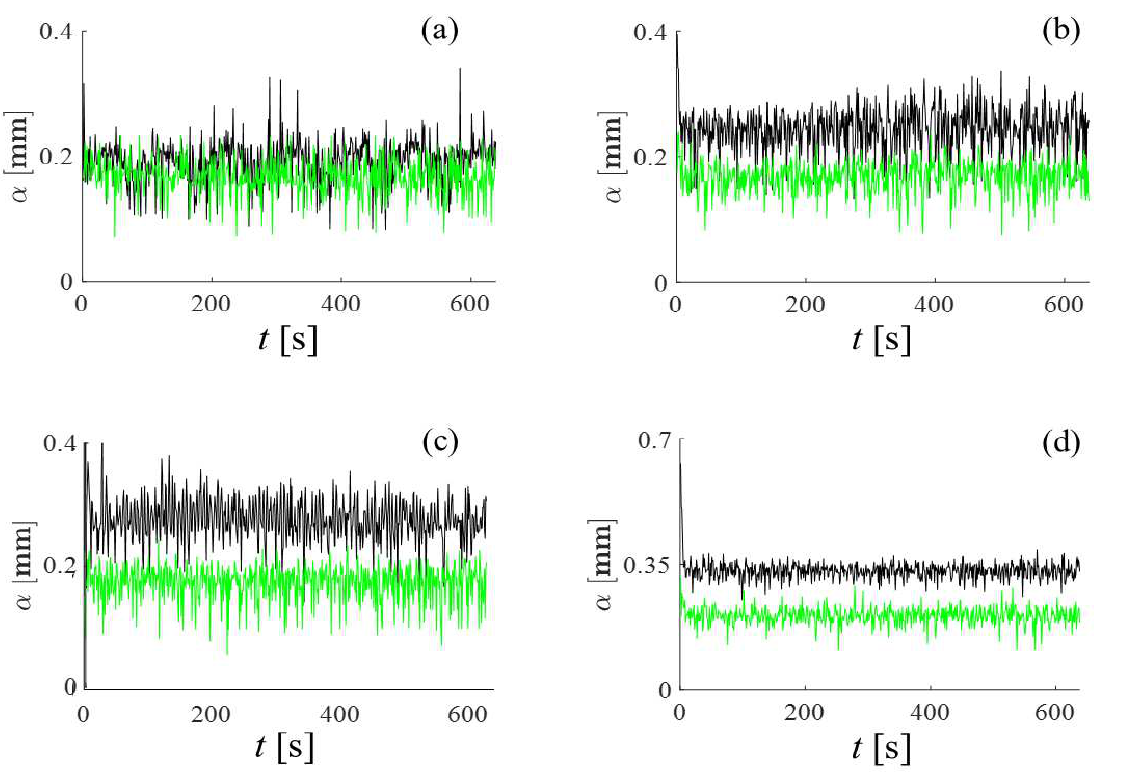
Figure 5: The interface position α obtained from 1D velocity profiles acquired every 1 s as a function of time following shear startup to (a) 7 s −1 , (b) 9 s −1 , (c) 12 s −1 and (d) 15 s −1 . The black line is protocol 1 (no pre-shear) and the green line is protocol 2 (with